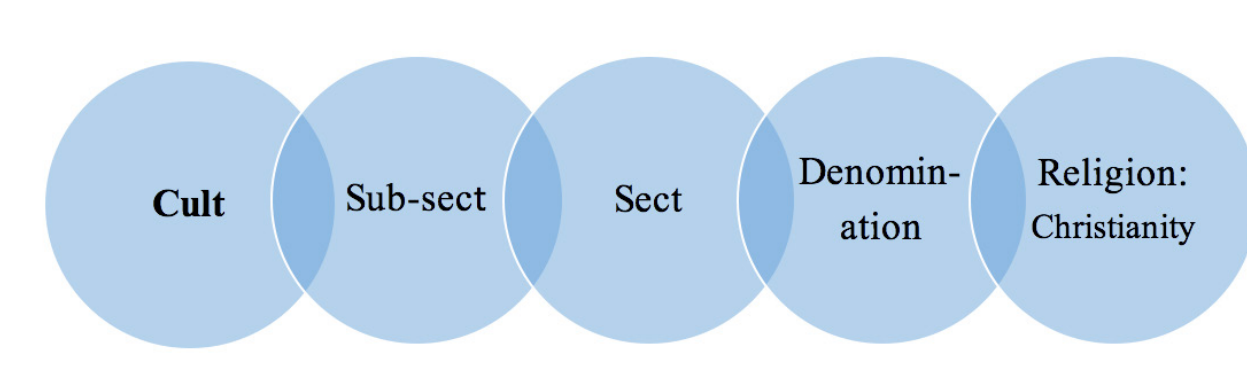
Figure 1: Christian-based typological continuum from cult to